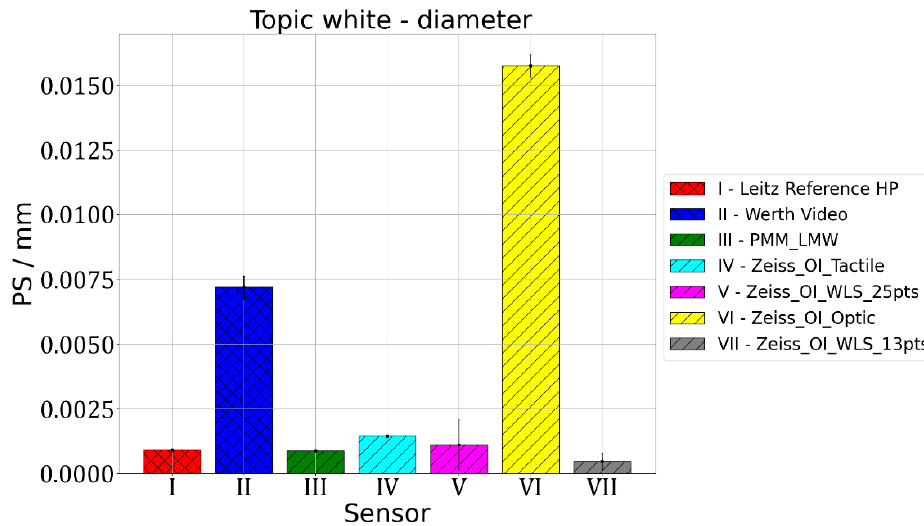
Figure 3. Results of measurements of sphere diameters for sphere made of Topic White.